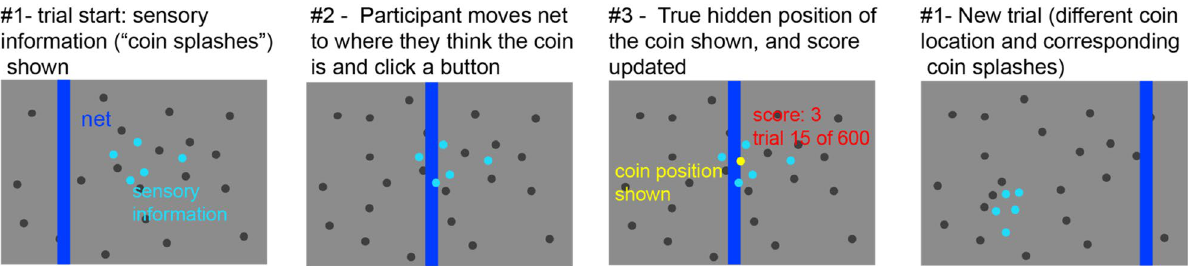
Figure 2. Experimental procedure. In this task, participants have to guess the hidden position of a target based on noisy information. They are told that they have to find a coin (yellow dot, which is hidden) and place the net (blue vertical bar) where they think the coin is. Furthermore, they are told that the person throwing the coin is aiming at the center. At the beginning of each trial, they are shown a cloud of light-blue dots and told that these are the splashes that the coin makes when it falls. Participants can move the blue net to where they think the coin is, and then press a button signaling their decision. Once they make the decision, they are shown the actual position of the coin in that trial, and get a point added to their score if the net covers at least half of the coin. The position of the coin is drawn from a Gaussian distribution (the “prior”) where the mean is the center of the screen and the variance is either large or small (P, σ 2 P = 0.085 2 , and p, σ 2 p = 0.025 2 , respectively, in unit-less screen coordinates). The sensory information, or likelihood, consists of 5 light blue dots which are taken from another Gaussian distribution where the mean is the position of the coin at that trial, and the variance is either large (L, σ 2 l = 0.15 2 ) or small (σ 2 l = 0.06 2 ). The experiment is divided in blocks of 150 trials each, and within a block the prior remains constant. Each prior type is shown twice, for a total of 4 blocks (2 types of prior variance * 2 block repetitions) and 600 trials (150*4). The sensory information varies from trial to trial, pseudo-randomly (so that there are 75 trials of each type of likelihood per prior block). This task is identical to the one used in 17 . For more details, see “Methods”.